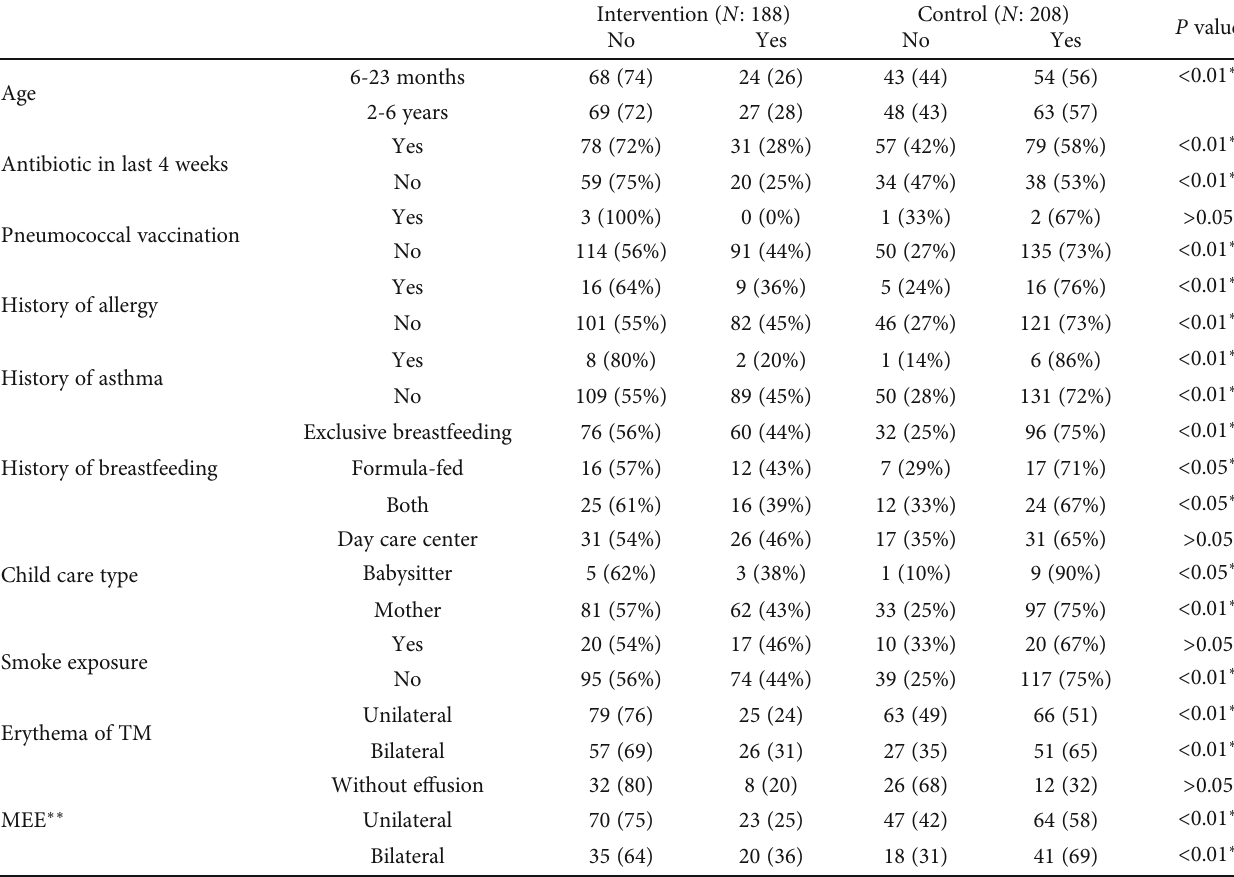
Table 3: Association between treatment response and di ff erent factors.